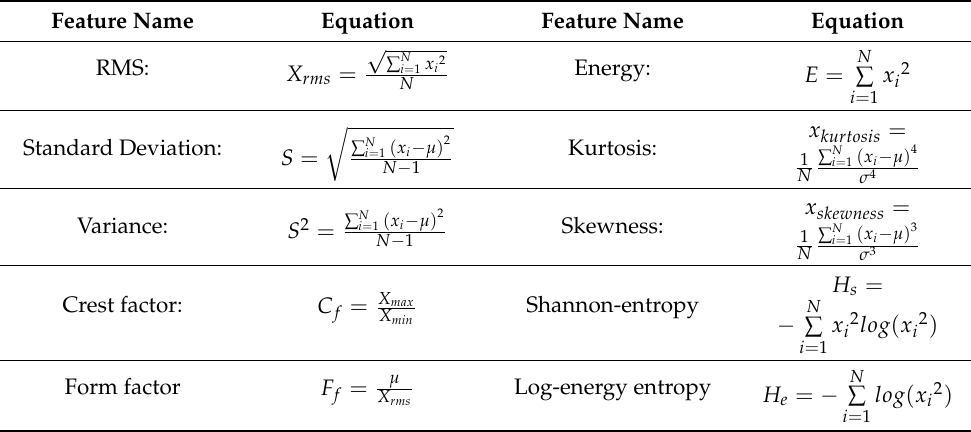
Table 5. List of extracting statistical features from the residual signal.